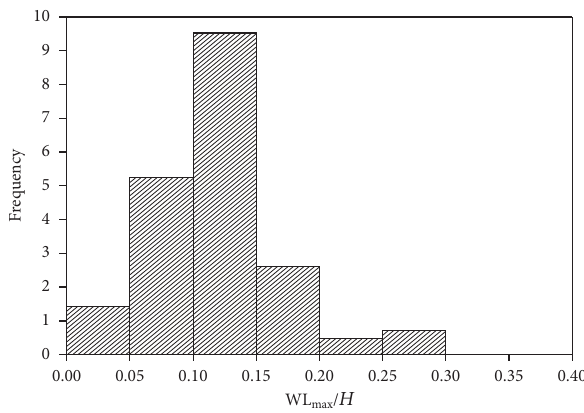
Figure 14: Frequency histogram of the maximum influence width coefficient along the X axis.